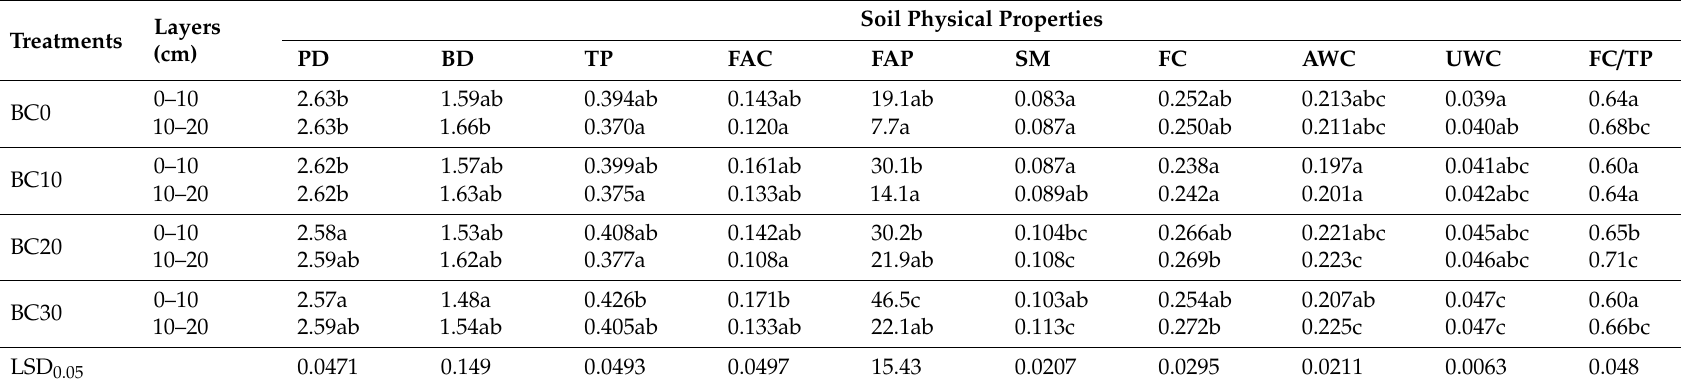
Table 2. Mean values of soil physical properties for layers (0–10 cm and 10–20 cm) in the 2010–2019